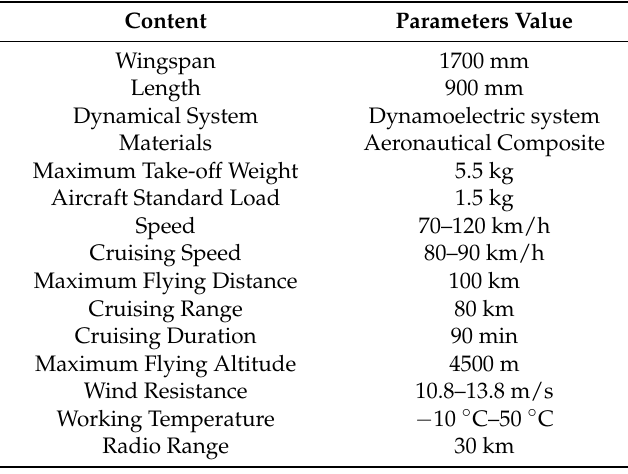
Figure 2. The scene of ancient trees investigation. Table 1. Parameters of YS-500 Fixed-Wing